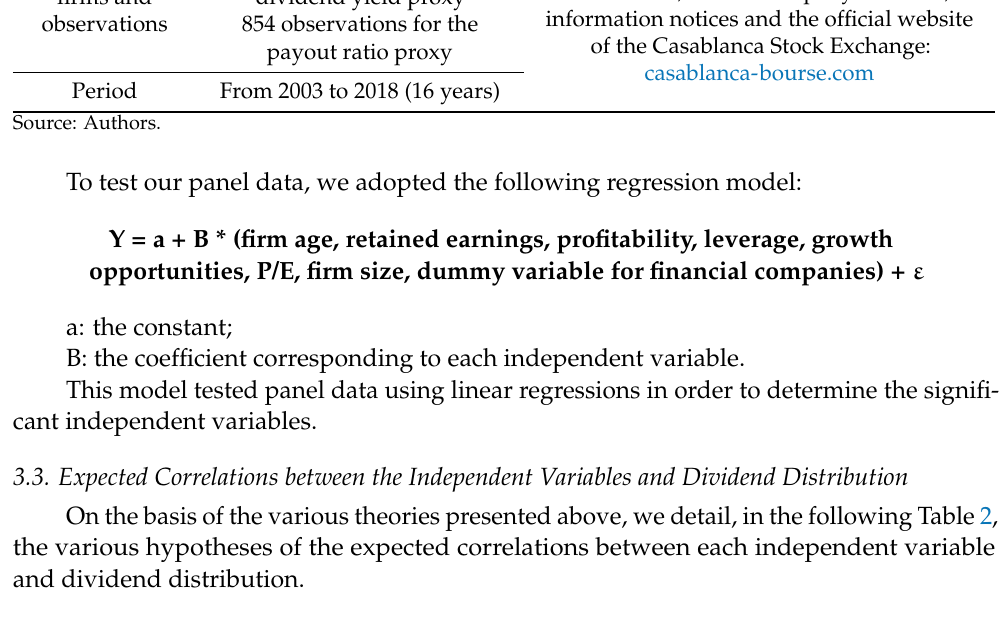
Table 2. Hypotheses of the predicted correlations between the independent variables and dividend